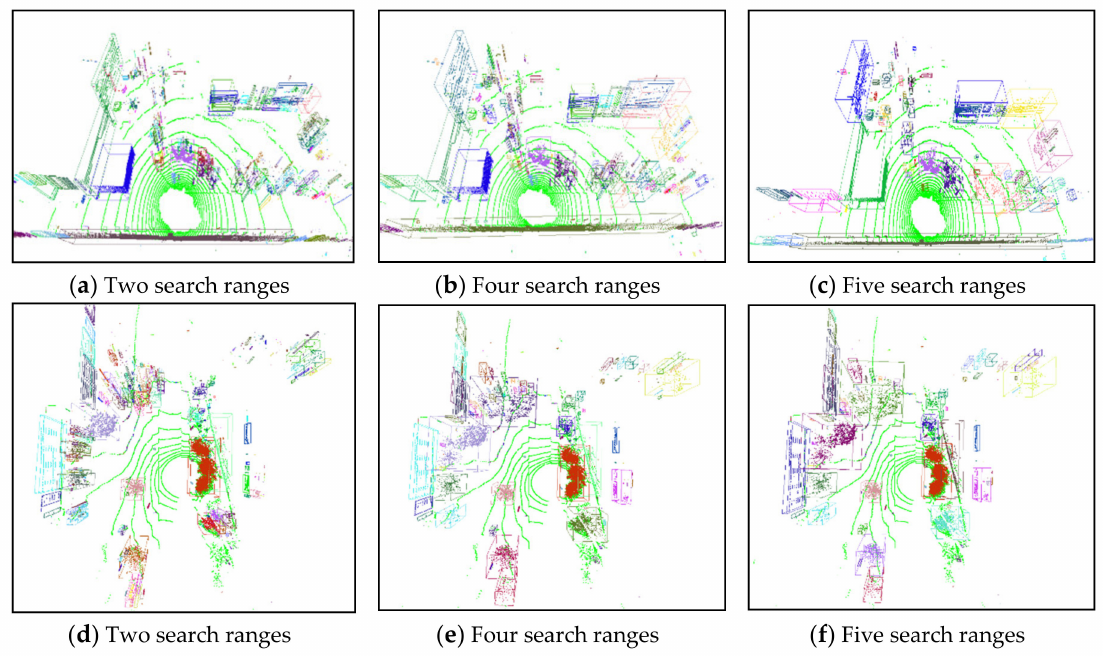
Figure 8. Obstacle clustering results obtained with di ff erent numbers of search ranges on di ff erent datasets: ( a – c ) clustering results of our collected dataset; ( d – f ) clustering results of NCLT